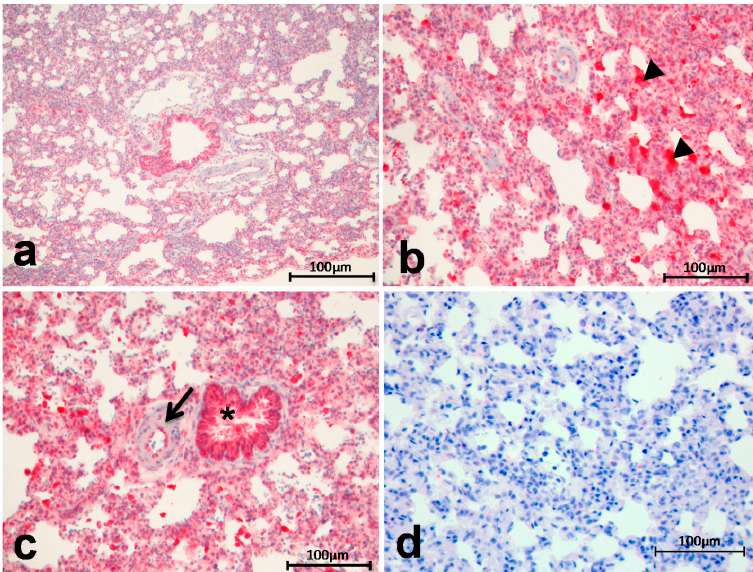
hypertension (IPH) rats ( b – c ) compared to the controls ( a ) enhanced staining positivity in the lung parenchyma and in alveolar macrophages (( b ), arrowheads = alveolar macrophages) and mild to moderate positivity in endothelial cells of peribronchial arteries (( c ), arrow); staining intensity of the epithelium of the bronchioles is more or less equal to that occurring in normal tissue (( c ), *); negative